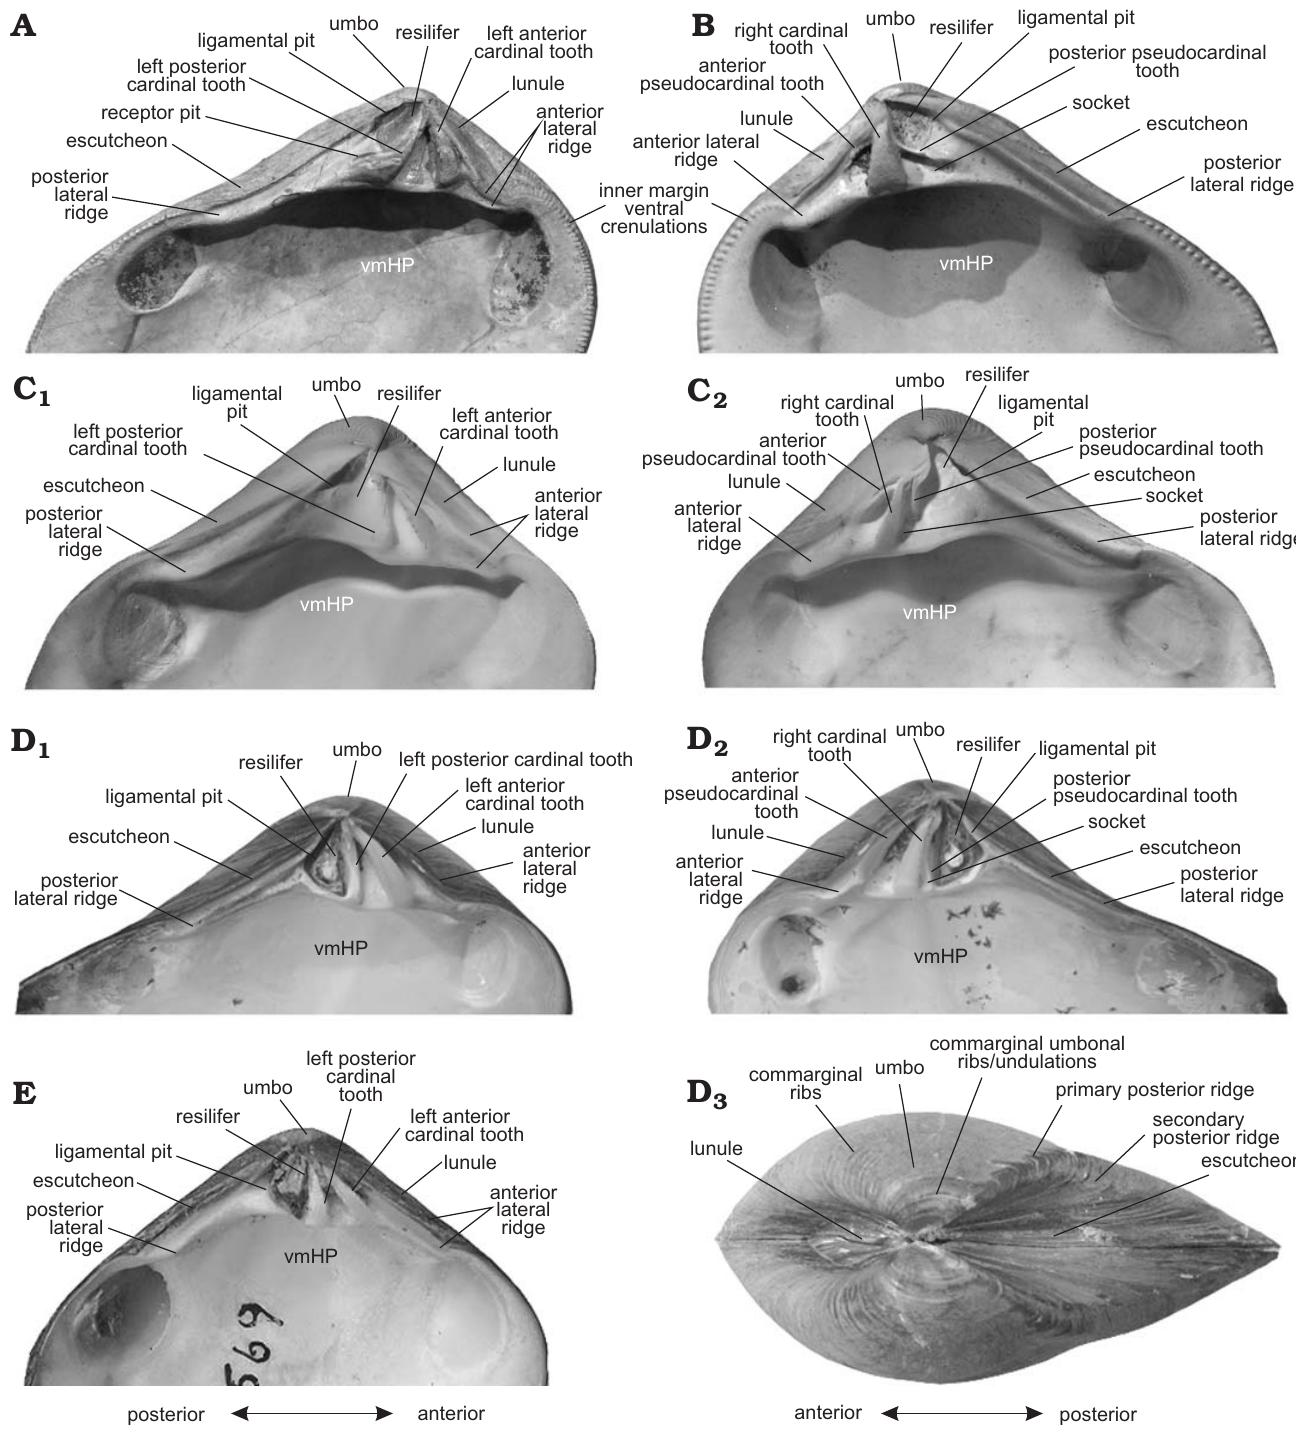
Fig. 2. Hinge characters and other features of crassatellines. A , B . Crassatella vadosa Morton, 1834, Cretaceous. A . USNM 450460, Mississippi, USA. B . USNM 451089, Alabama, USA. C . Eucrassatella kingicola (Lamarck, 1805), UWBM 101886, Recent, Victoria, Australia. D . Hybolophus gibbosus (Sowerby, 1832), SBMNH 213002, Recent, Gulf of California, Mexico. E . Hybolophus fluctuatus (Carpenter, 1864), SBMNH 137784, Recent, Santa Catalina Island, California. Left valves (A, C 1 , D 1 , E), right valves (B, C 2 , D 2 ), valve in dorsal view (D 3 ). Abbreviation: vmHP, ventral margin of the hinge